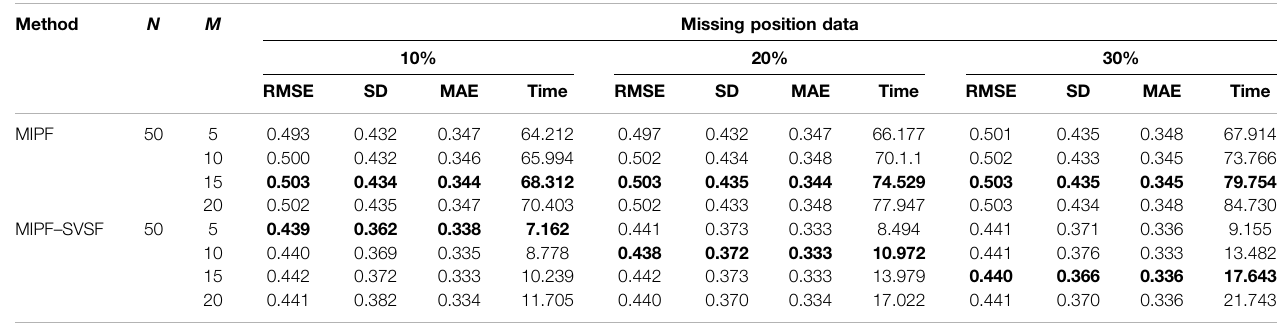
TABLE 2 | The performance of the MIPF and MIPF – SVSF during missing position data.